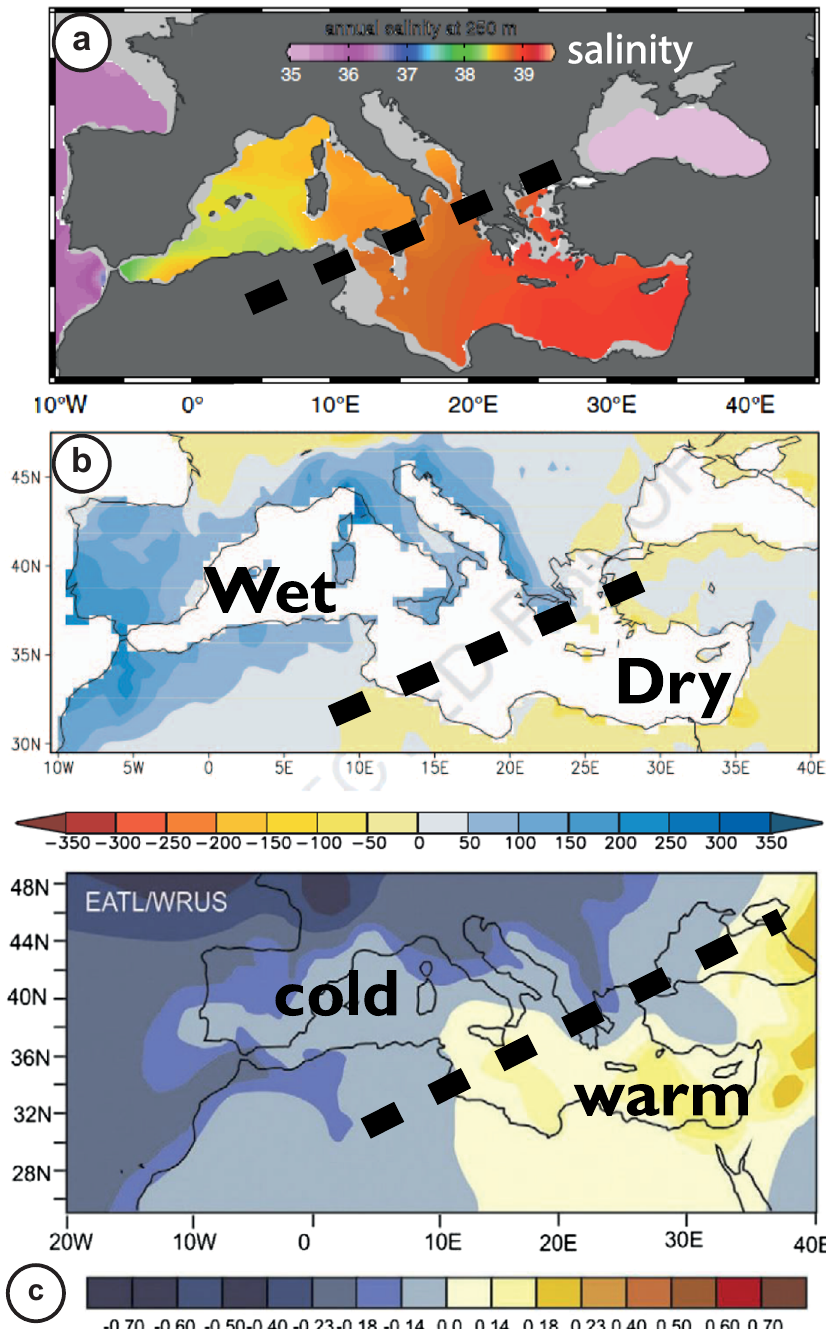
Figure 1: Sea - Saw and EA/WR e ff ects in Mediterranean. ( a ) Mean annual surface salinity in the Mediterranean Sea ( after Soukissian et al., 2017 ) , ( b ) wet/dry Mediterranean winter in 1838 after dendroclimatological data ( after Luterbacher et al., 2006 ) , and ( c ) east Atlantic/W.Russia atmospheric con fi guration ( after Benito et al., 2015 )